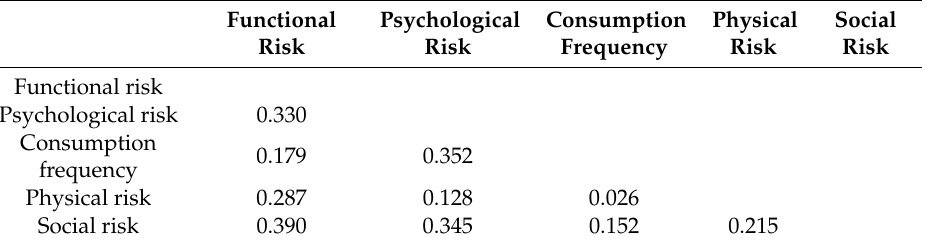
Table 6. Heterotrait-monotrait (HTMT) criterion for discriminant